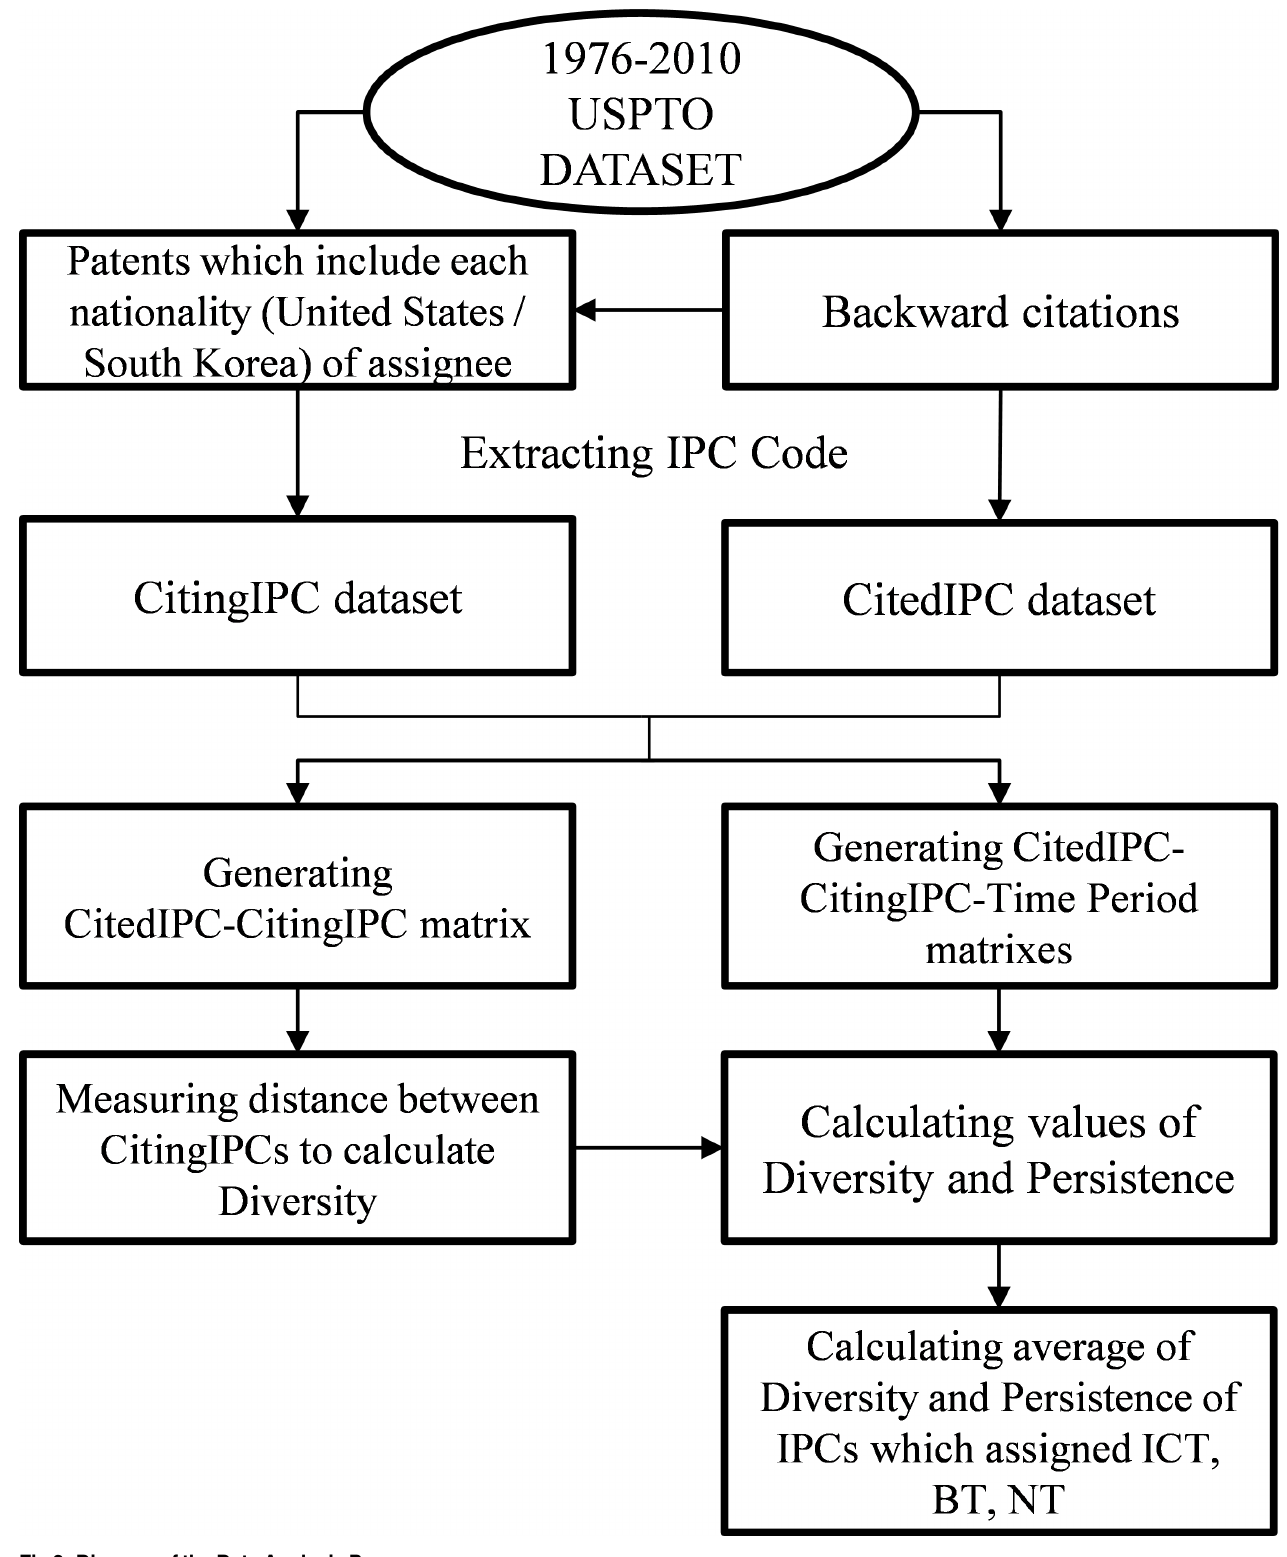
Fig 2. Diagram of the Data Analysis Process.